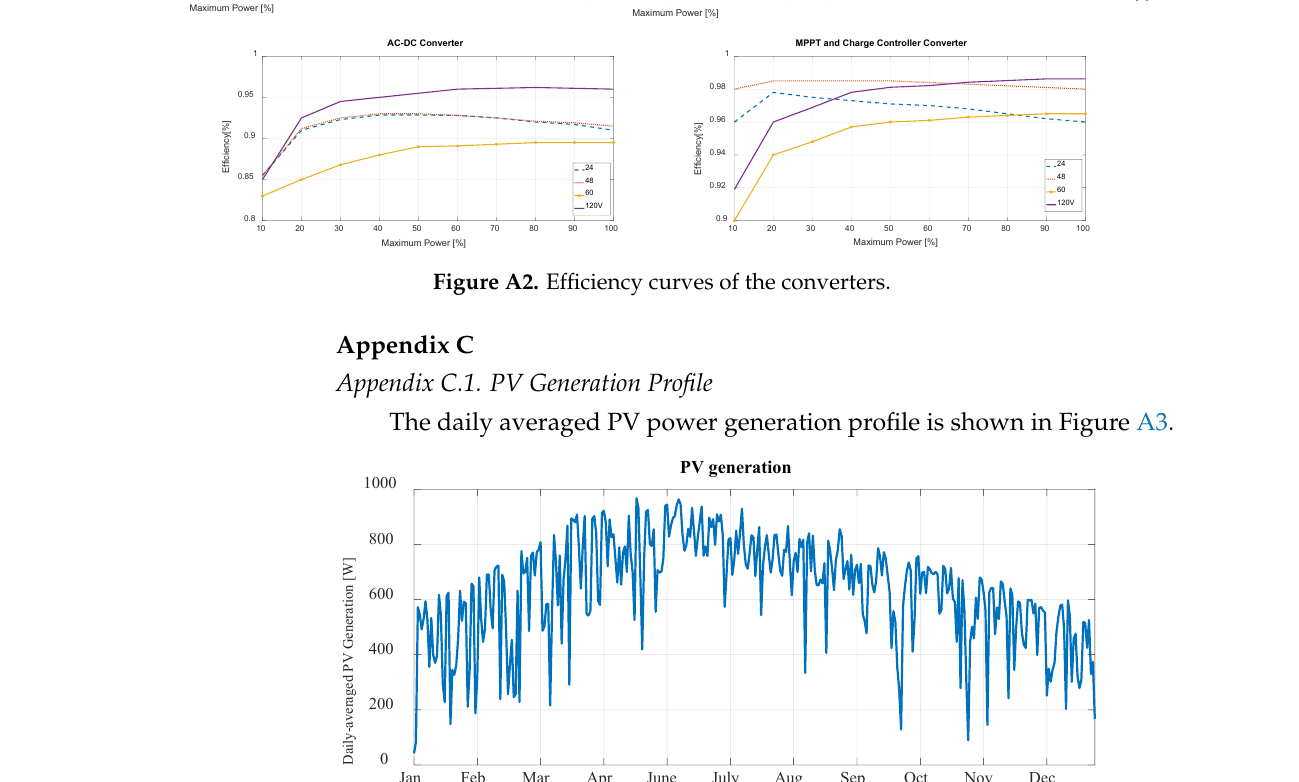
Figure A3. Annual PV power generation.